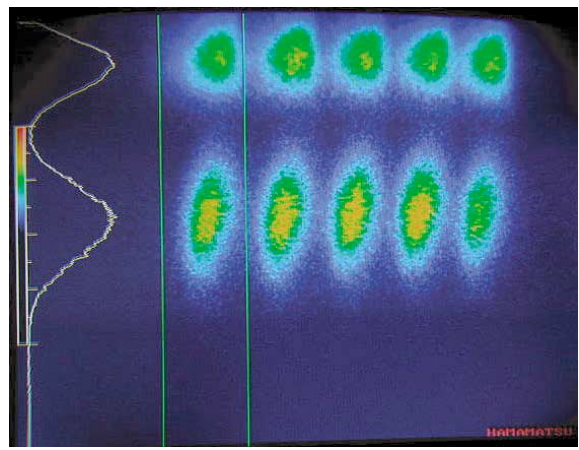
FIG. 31. (Color) A typical streak camera image of stable collid- ing beams in CESR. Bunch one in the train is to the left-hand side and bunch five is to the right-hand side on the horizontal axis. The train on the top is positrons, and on the bottom are electrons. The longitudinal profile is on the left-hand side of the figure. Under stable conditions, the bunches line up vertically.